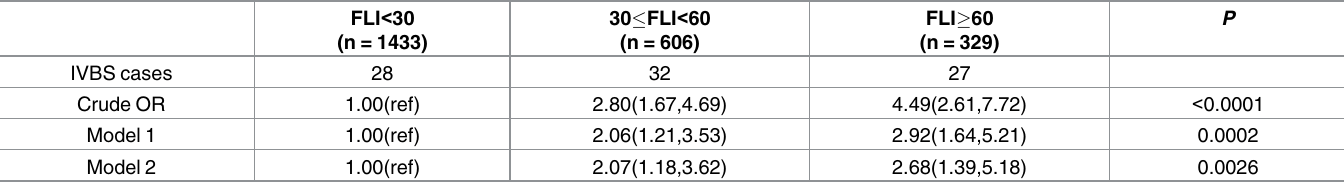
Table 2. Associations of FLI with IVBS in cross-sectional analysis.